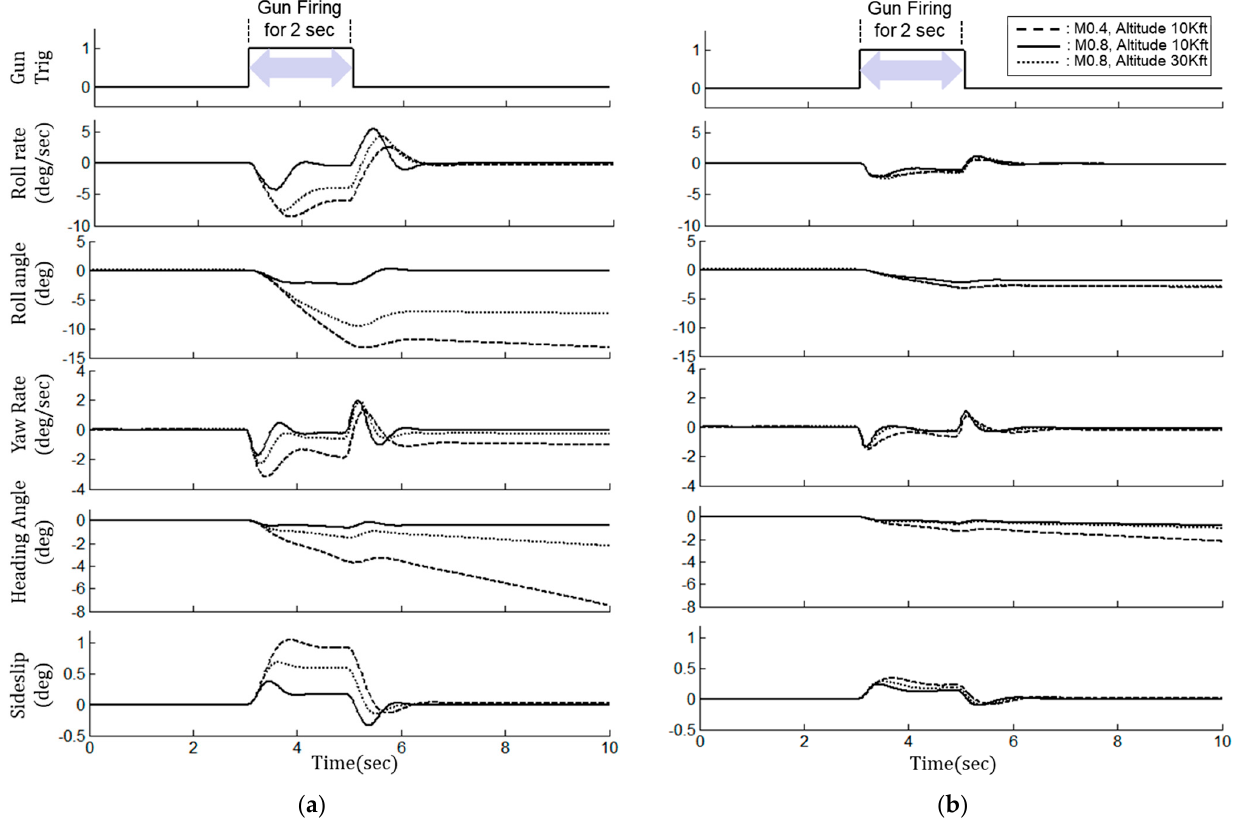
Figure 11. Result of robustness in gain scheduling for each control method at M0.4, 10 kft altitude: ( a ) the fixed control gain of the gun compensation control designed at Mach number 0.8 and altitude 10 kft; ( b ) the additional augmentation control with 𝑲 (cid:3028)(cid:3048)(cid:3034) set to 0.8.